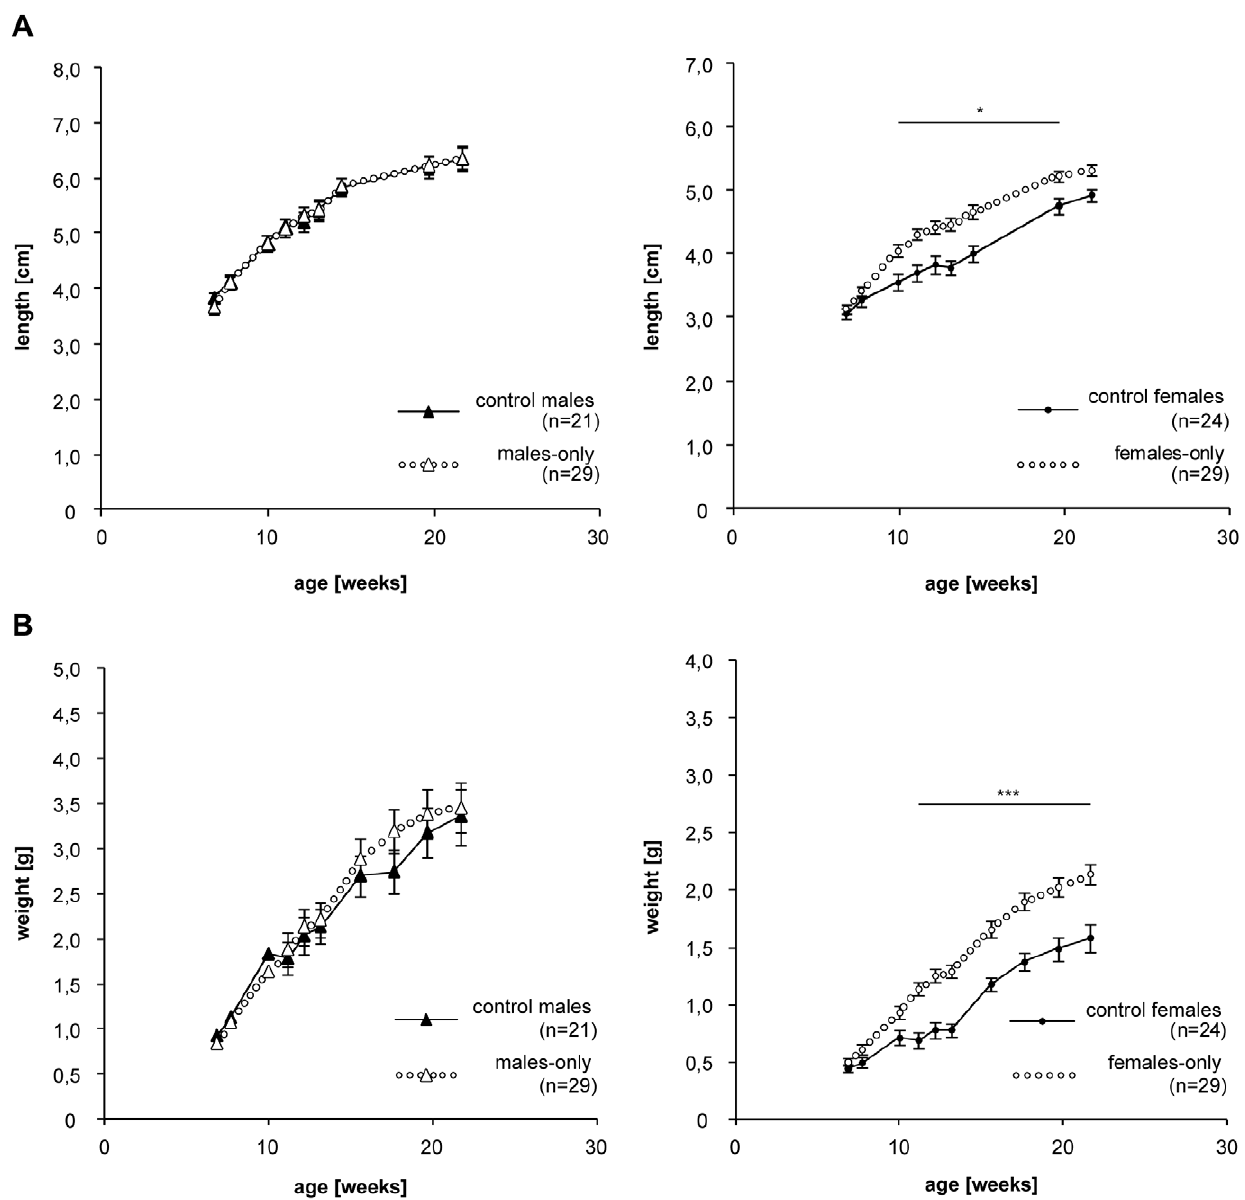
Figure 2. Age dependent changes in mean body weight and size in gender separated and control animals. Determination of length (A) and body weight (B) of males-only and control males (left) and females-only and control females (right). Graphs show mean 6 sem. Significance for given data points were calculated by Bonferroni post hoc test.